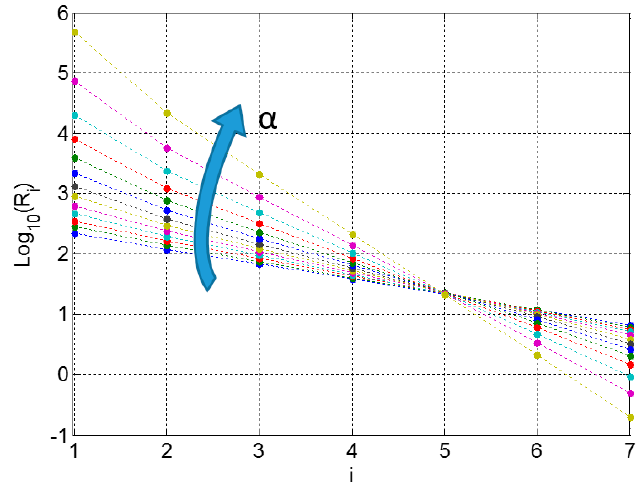
Figure 5. Variation of the resistances R i as function of α (variable between 0.3 and 0.7).